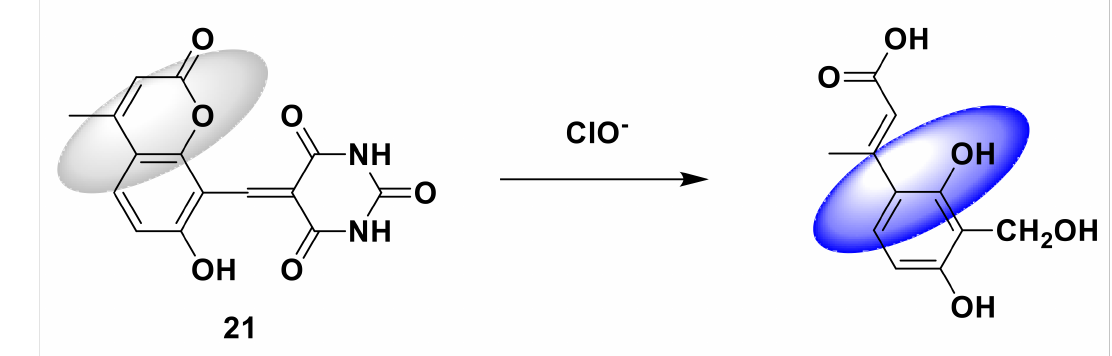
Figure 21. The reaction of probe 21 and ClO − .